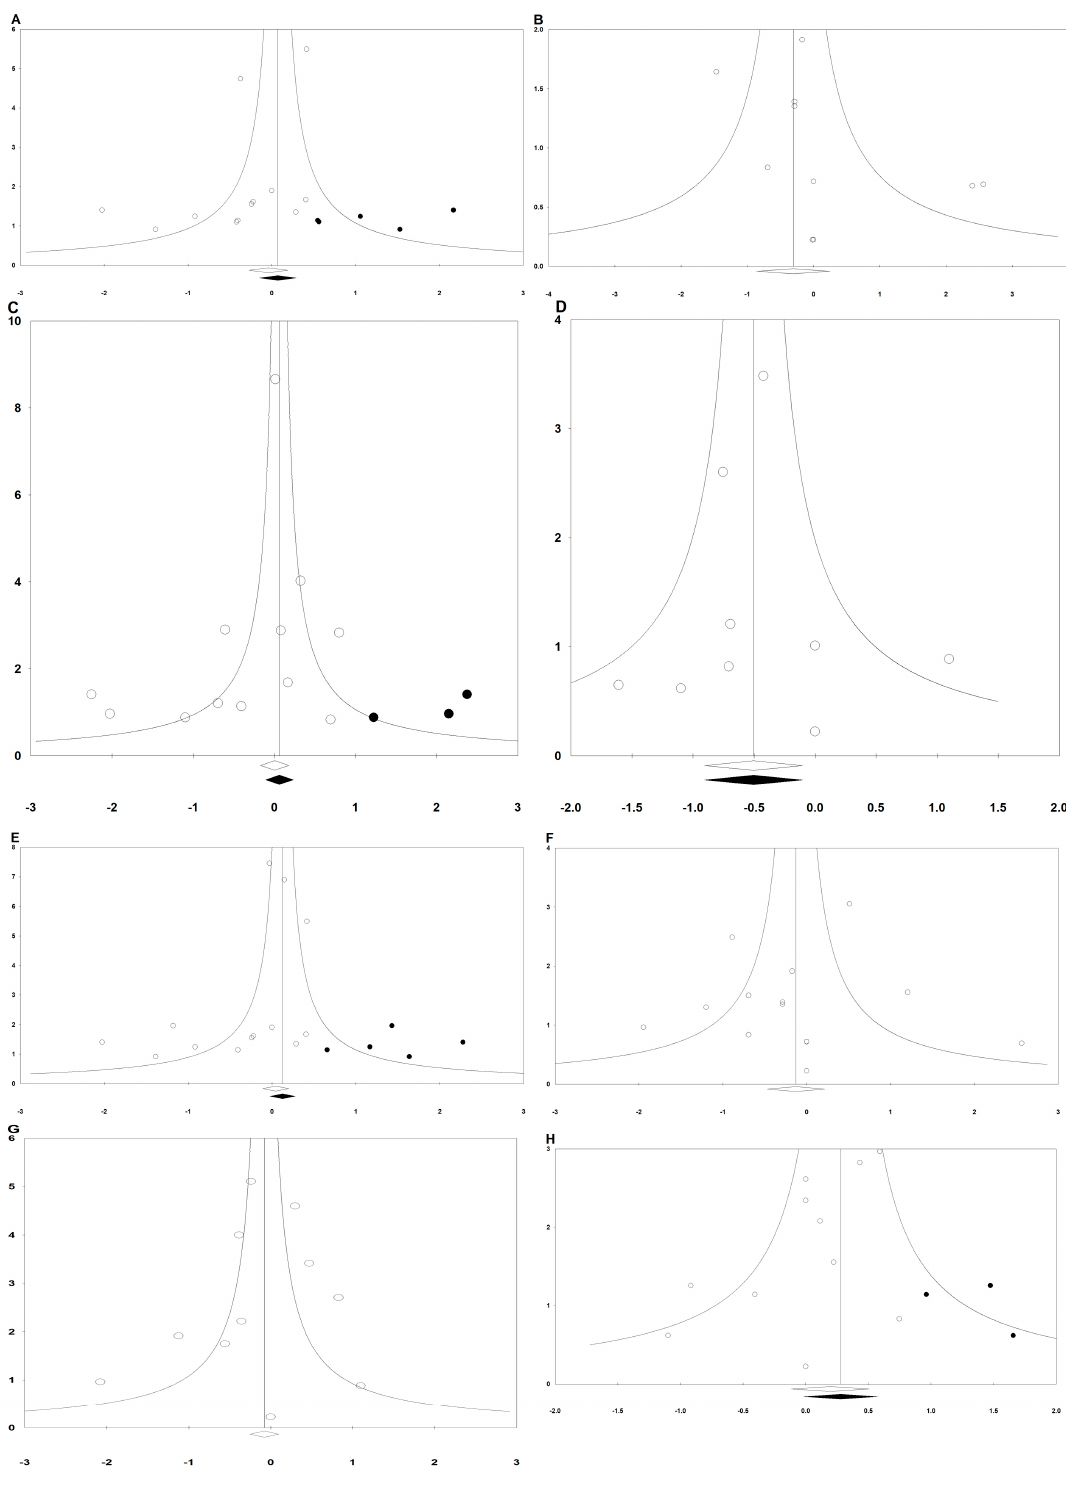
Figure 7. Funnel plots of ( A ) early PON, ( B ) early POV, ( C ) late PON, ( D ) late POV, ( E ) overall PON, ( F ) overall POV, ( G ) rescue antiemetics, and ( H ) headache. The horizontal axis demonstrates the log of risk ratio, and the vertical axis shows the inverse of the standard